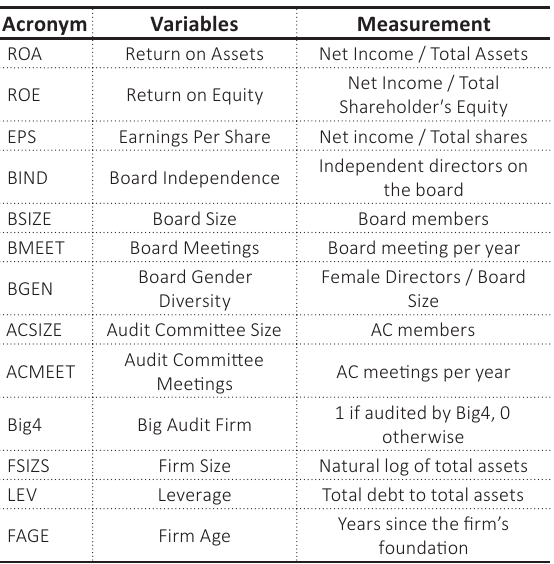
Table 2. Summary of the operationalization of the